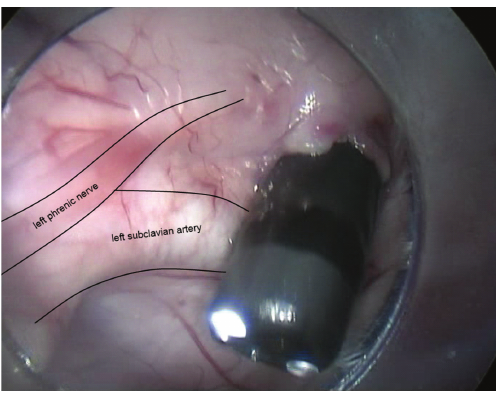
Figure 2: Transthoracic visual control of transesophageal port creation in the upper third of the esophagus (porcine